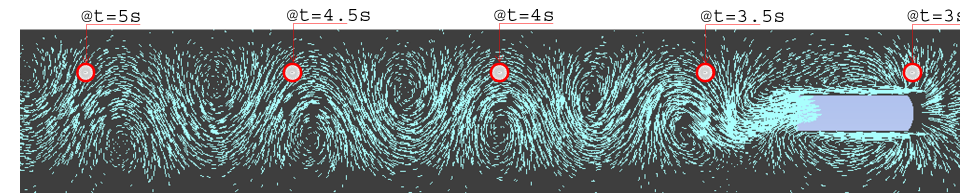
Figure 14. ( a ) Instantaneous wind direction at the rotor zone for bus model; ( b ) Instantaneous wind magnitude at the rotor zone for bus model.